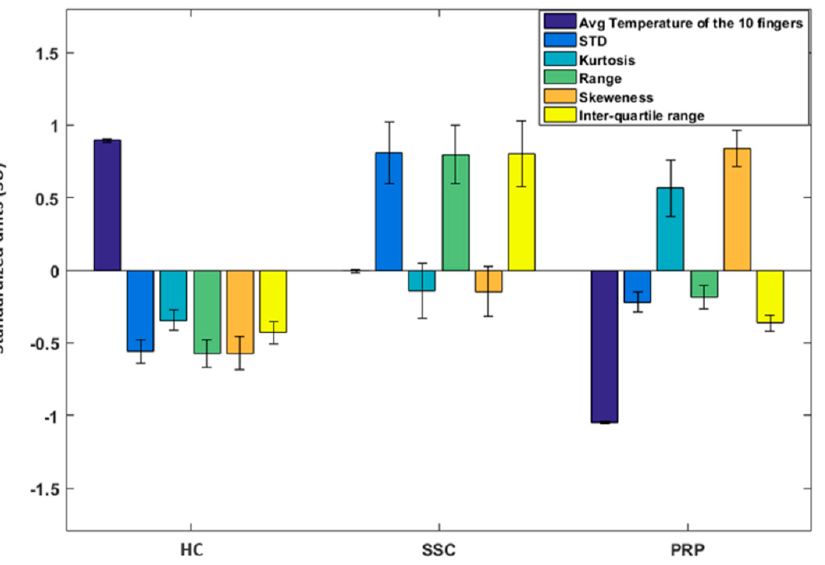
Figure 4. Group average values and the related standard deviation of each feature z-score normalized. The measurement units reported on the y-axis are the standardize units since the features shown are z-score normalized.